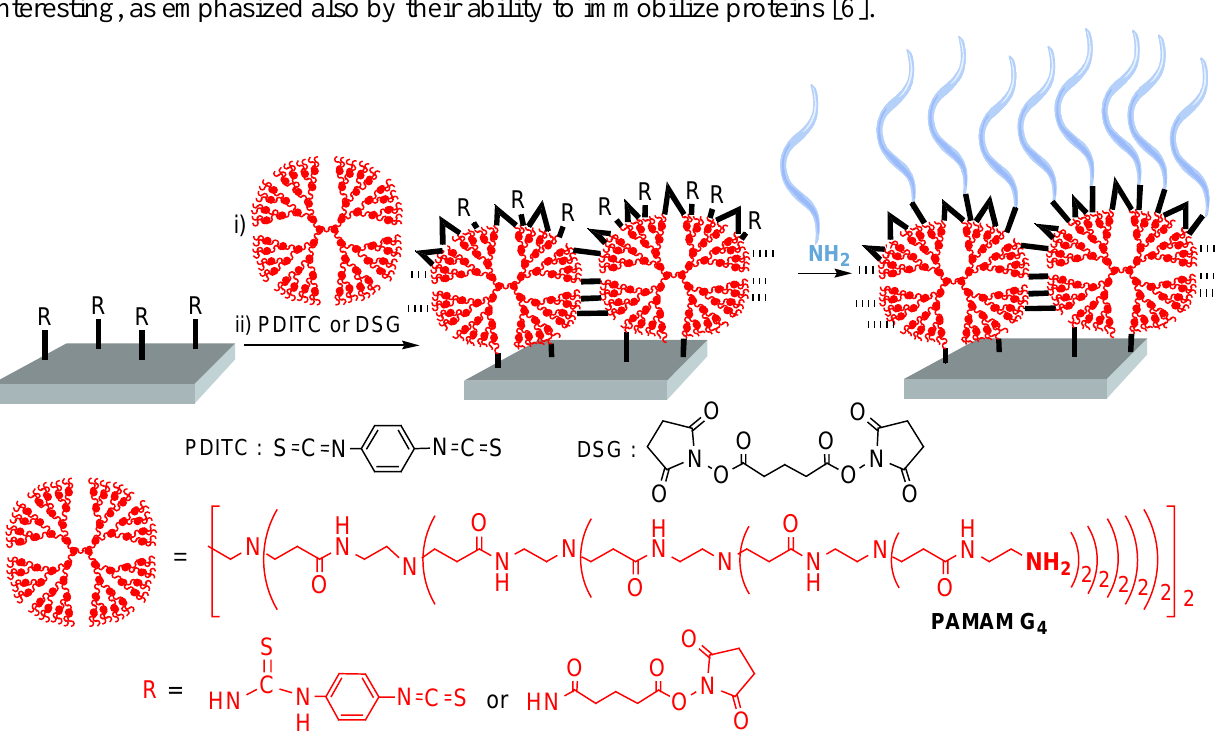
Figure 4. Grafting of PAMAM dendrimers on a surface, then cross-linking and activation using PDITC or DSG, to allow the grafting of amino-modified